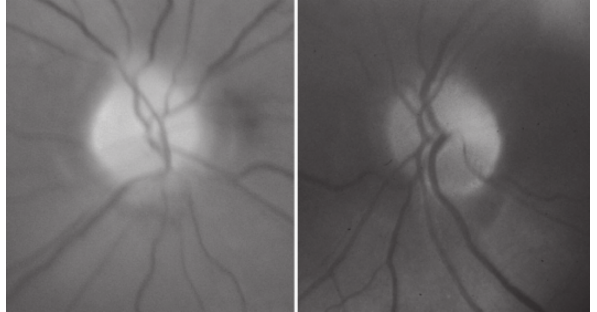
Figure 1 - Fundus photograph 40 days after visual loss showing small (“crowded”) optic discs with pallor most prominent superiorly in both